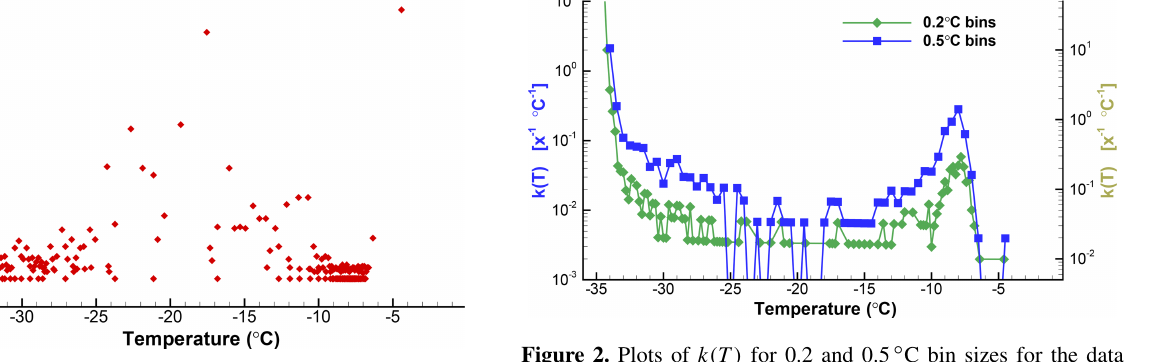
Figure 1. Temperature gaps between successive freezing events in the data given in Table 1. Fewer events in the middle range of tem- peratures produce fewer and larger gaps.